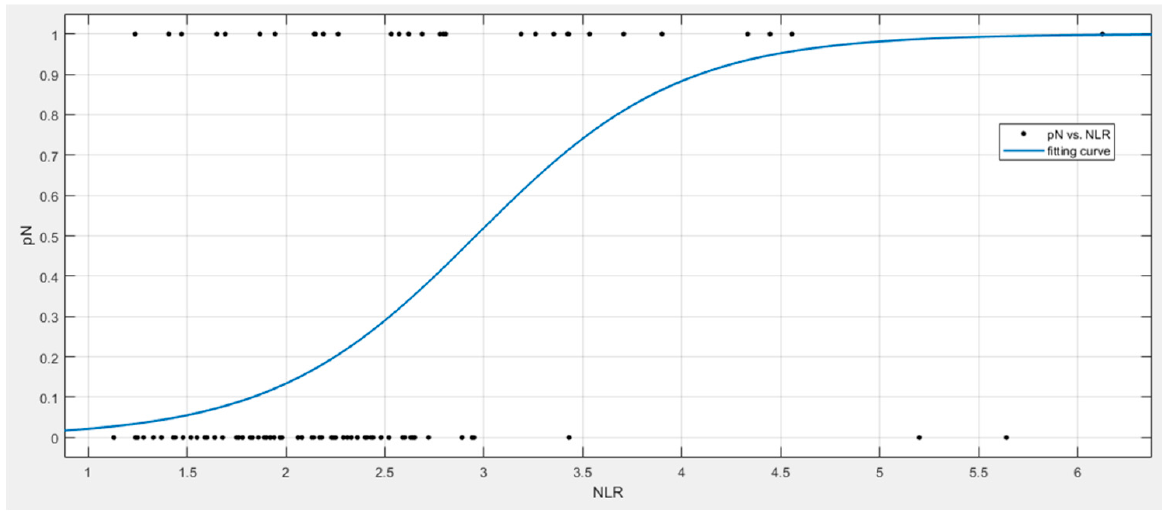
Figure 2. Graphical representation of our statistical model of the NLR. The overlapping of PLR values in the PN0 and PN+ groups did not allow us to identify any Intercept and β values in the logistic regression model for the